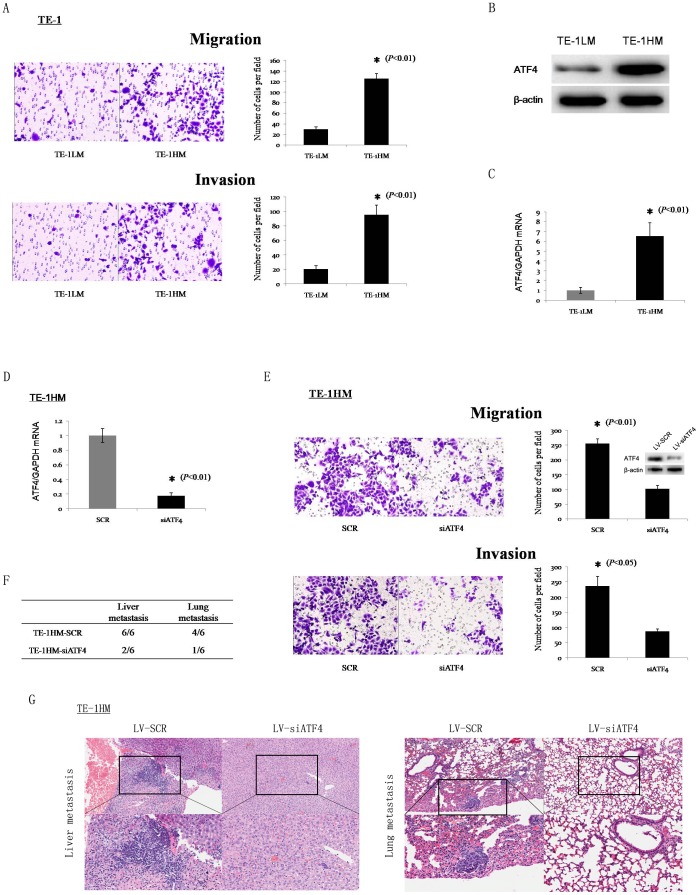
ATF4 silencing attenuates migration, invasion, and metastasis of ESCC cells.(A) The in vitro migration and invasion of the TE-1LM and TE-1HM cell sublines were examined by in vitro migration and invasion assays. Representative microscopic images of the underside of the transwell membrane are shown. Magnification, 200×. The bar graphs represent the average number of cells on the underside of the membrane ± S.D. The protein (B) and mRNA (C) levels of ATF4 in the TE-1LM and TE-1HM sublines were examined by Western blotting and qPCR. β-actin and GAPDH were used as internal controls, respectively. The data represent the means ± S.D. of three independent experiments. (D) ATF4 mRNA levels in the TE-1HM cells that were stably transfected with LV-SCR and LV-siATF4 were detected by qPCR. (E) In vitro migration and invasion assays of the TE-1HM cells that were stably transfected with LV-SCR and LV-siATF4. Inset, relative ATF4 protein expression levels as determined by Western blot. (F) Incidence of metastasis in mice implanted with TE-1HM-SCR or TE-1HM-siATF4 cells. (G) Representative hematoxylin and eosin staining of the lungs and livers of mice.